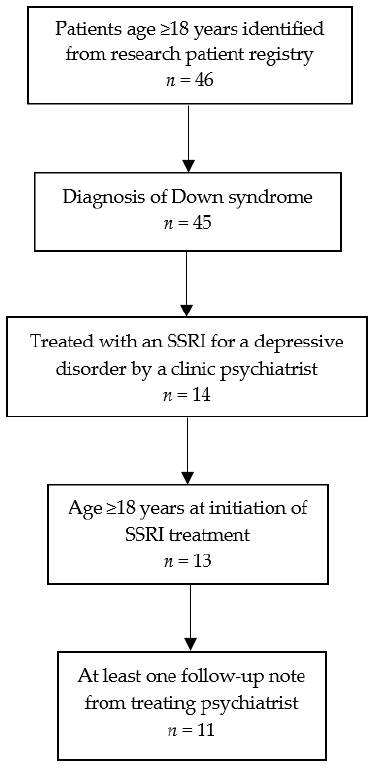
Figure 1. Flow diagram of identification of patients in the study. SSRI: selective serotonin reuptake inhibitor.